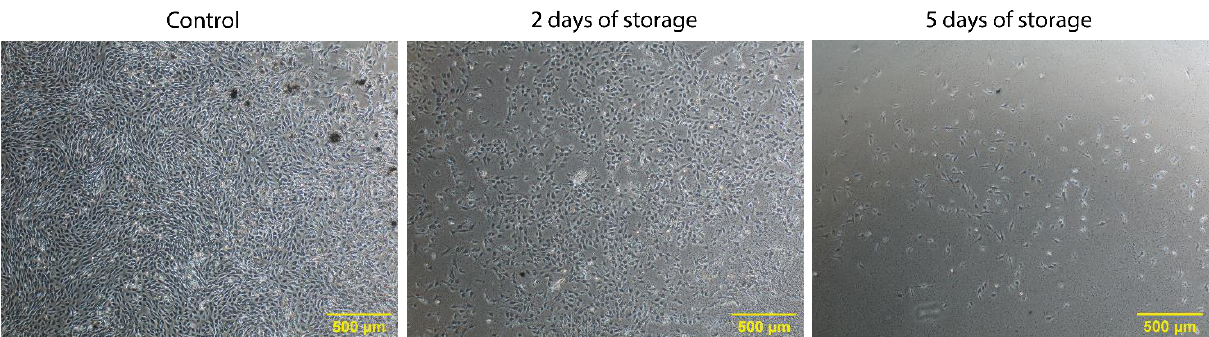
Figure 1. Representative phase contrast images of isolated cells after 6 days of cultivation. Cells isolated from fresh tissue (control) and after 2 and 5 days of storage. The images were obtained 6 days after thawing the cryopreserved isolates. Scale bar = 500 µm at 10x magnification.